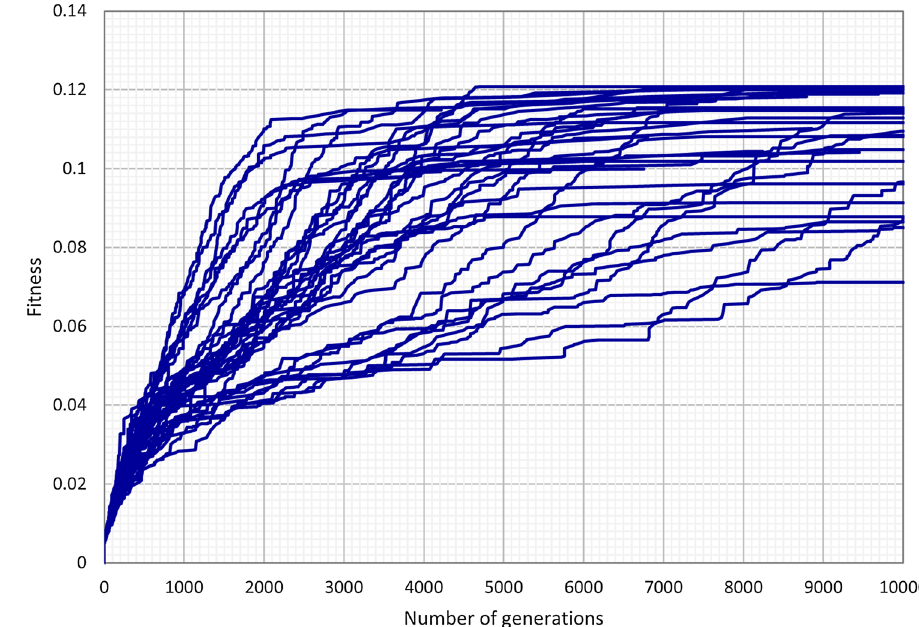
Fig. 6 Genetic algorithm